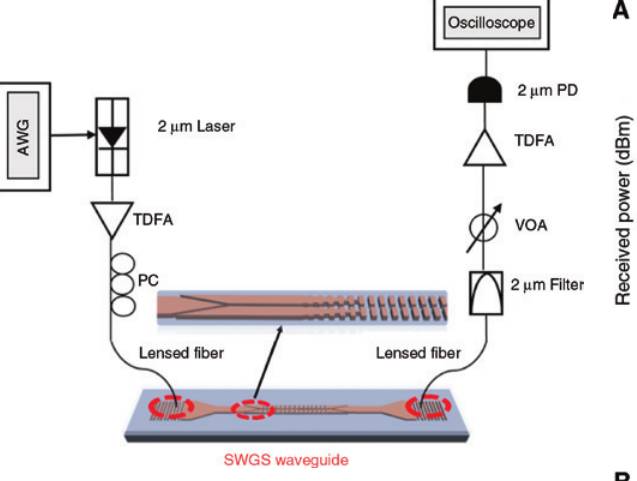
Figure 8: Experimental setup for chip-scale data transmission through the fabricated silicon-based SWGS waveguides. AWG, arbitrary waveform generator; PC, polarization controller; TDFA, thulium-doped fiber amplifier.